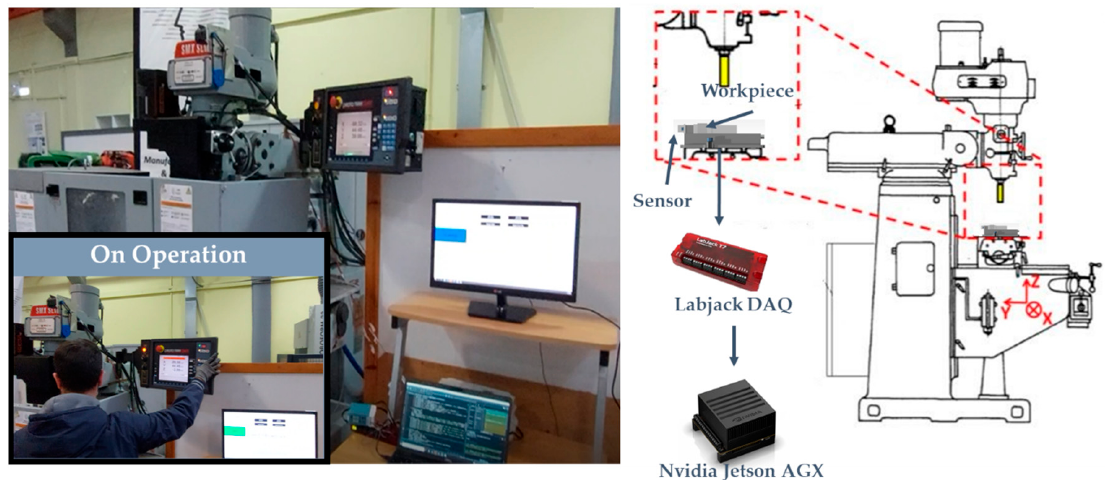
Figure 6. Overview of the overall monitoring system.